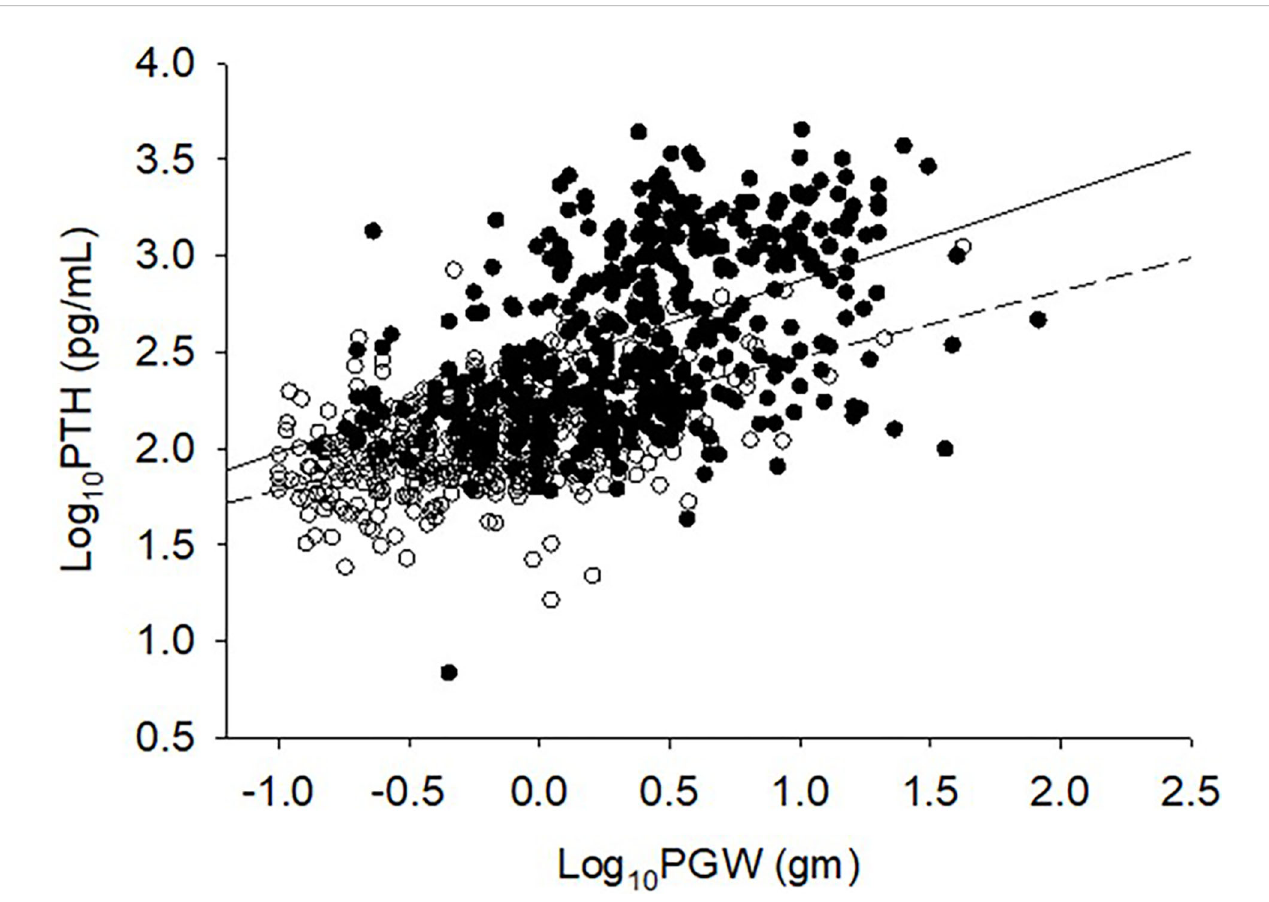
FIGURE 3 Relationship between serum PTH level and adenoma size. Detroit Cohort: Open circles and bottom solid line (n=426). Indian Cohort: Closed circles and top solid line (n=426). Data was log transformed because of non-normal distribution of both variables. Note the upward and rightward shift of Indian PHPT data. Slopes of regression are not different from each other, but the intercept is higher for the Indian